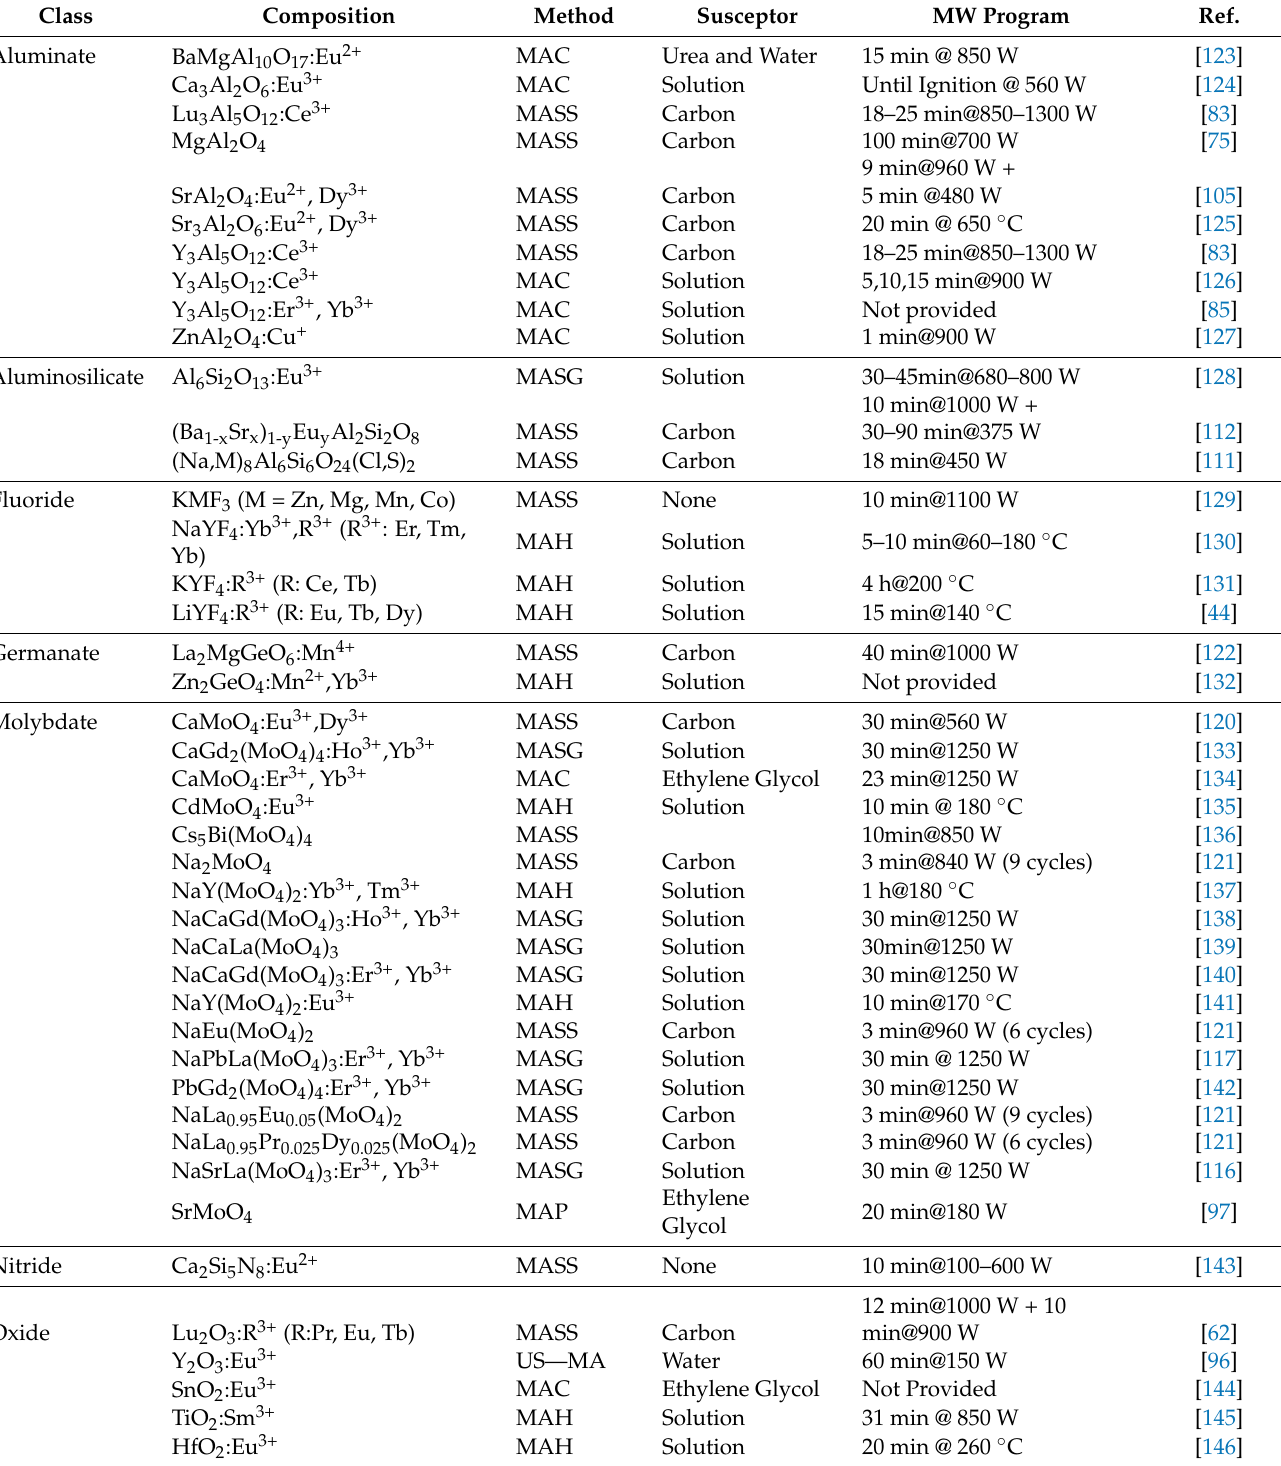
Table 4. Inorganic hosts for luminescent materials obtained by microwave-assisted